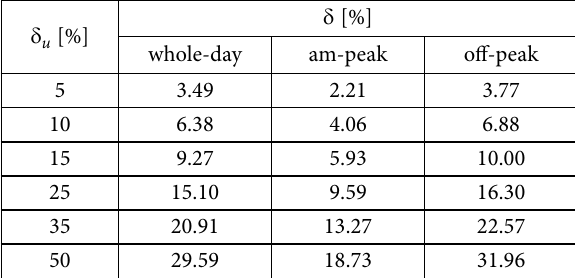
Figure 3. GT speed and flow observation data with average number of speed samplings for 1 min simulated FCD via MC simulations Table 2. d u and corresponding d values for different analysis